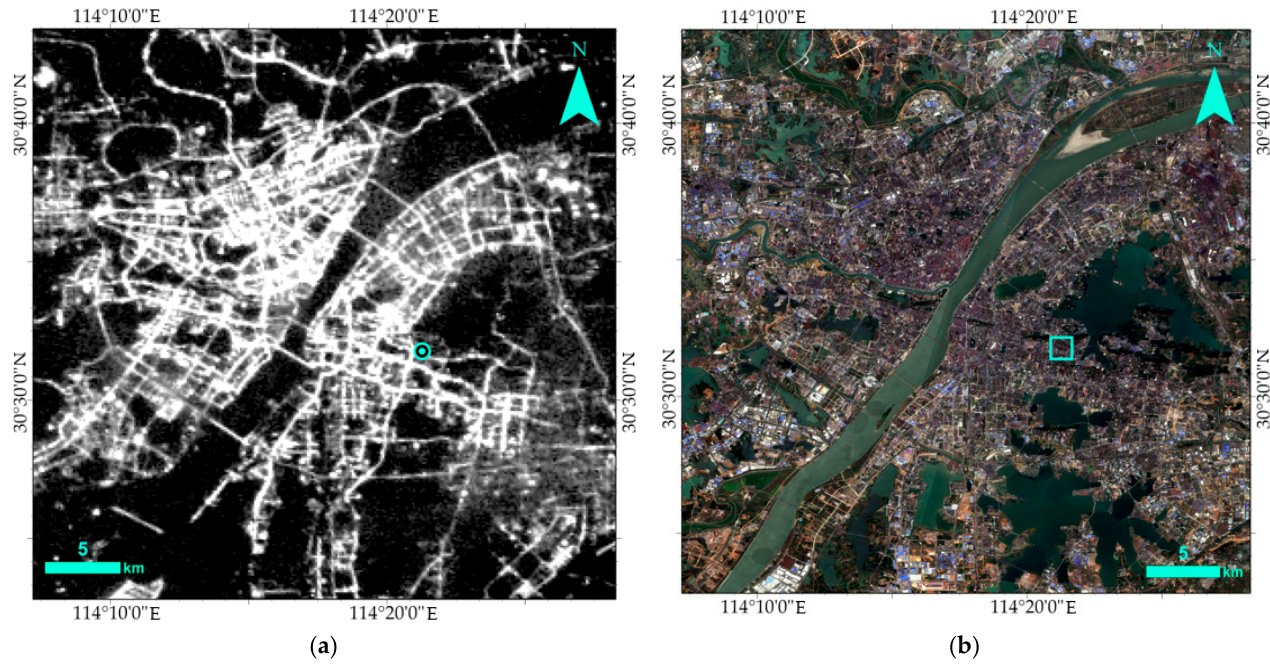
Figure 1. ( a ) NTL image of Luojia-1 at the study site. The dot indicates the location of the SQM device; ( b ) True color synthesis image of Sentinel II at the study site. Guangbutun region is framed by the square.